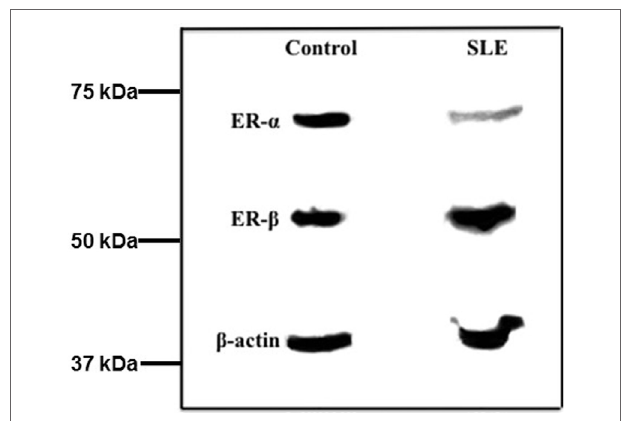
FigUre 2 | Western blots of freshly isolated T cell proteins indicate the amount of ER α but not ER β is less in systemic lupus erythematosus (SLE) patients compared with female controls. Fresh T cell extracts were size fractionated by SDS-PAGE and transferred to nitrocellulose membranes. The blots were sequentially reacted with antibodies to ER α , ER β , and β -actin. The relative amount of receptor subtype was measured by scanning densitometry and values were adjusted to β -actin in the same T cell